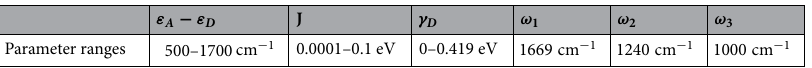
Parameter Table 1. Parameters for numerical solution 78,79 .